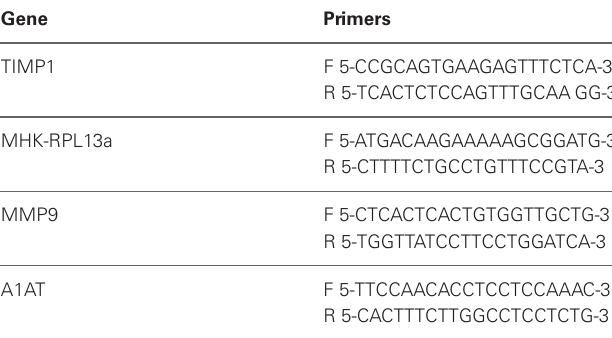
Table 1 | Primers used for RT-PCR.